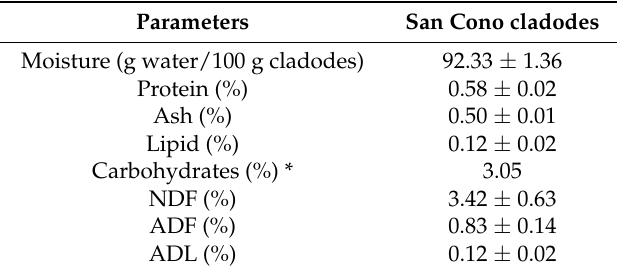
Table 1. Chemical composition (on a fresh weight basis) of Ficodindia di San Cono cladodes. Data are presented as mean values ± standard deviation ( n = 5). NDF = neutral detergent fiber; ADF = acid detergent fiber; ADL = acid detergent lignin. * = obtained by